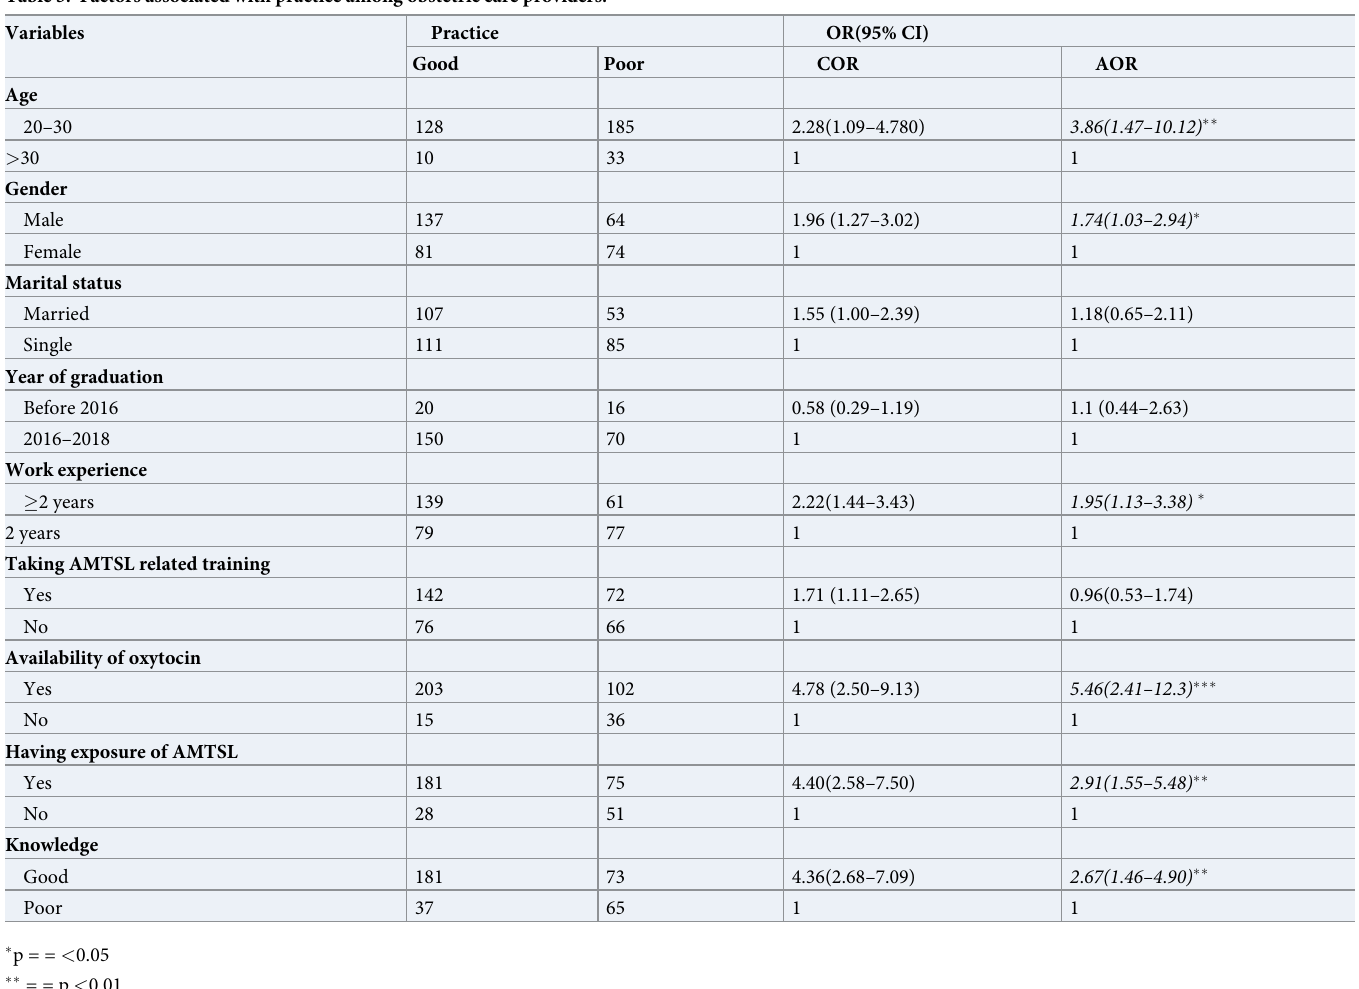
Table 5. Factors associated with practice among obstetric care